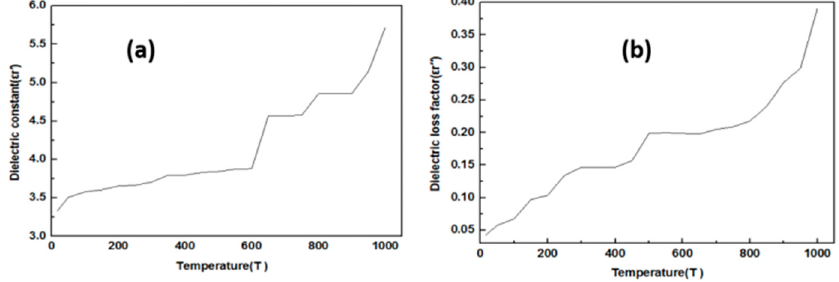
Figure 6. Dielectric constant ( a ) and loss factor ( b ) of chromite with temperature.